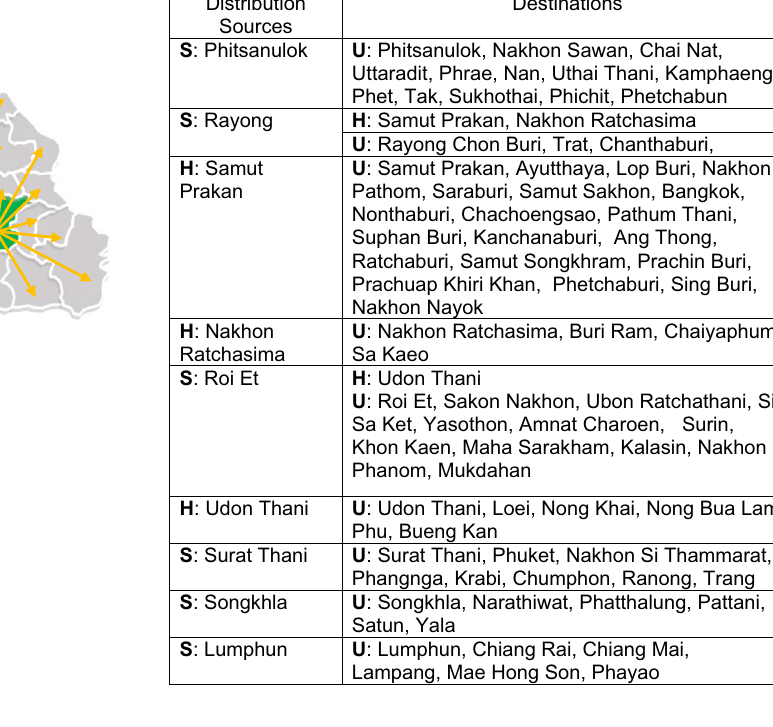
Figure 6. The locationf Figure 5. The location of facilities (storage areas or hubs) to their end users for scenario A on Thailand map created with Microsoft Office 365, Excel Version 1905 (https:// www. office. com/ launch/ excel?